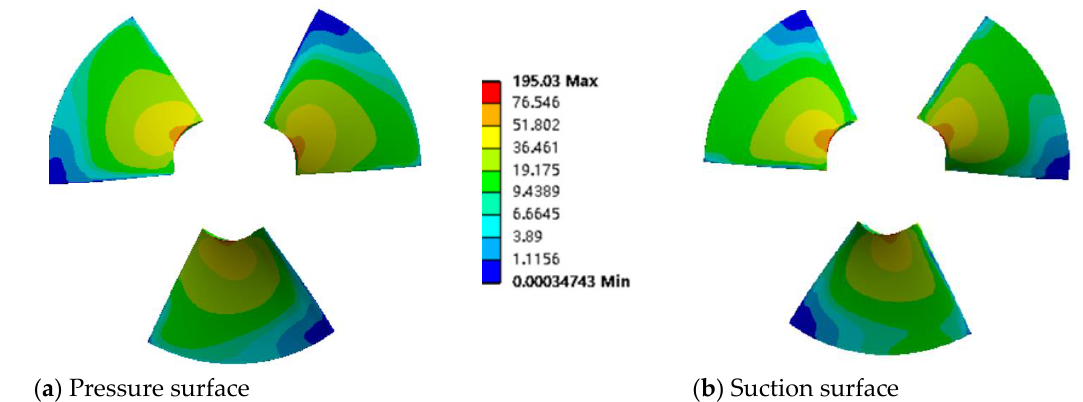
Figure 15. Q = 20 m 3 /s Equivalent stress distribution of impeller, Unit: MPa.